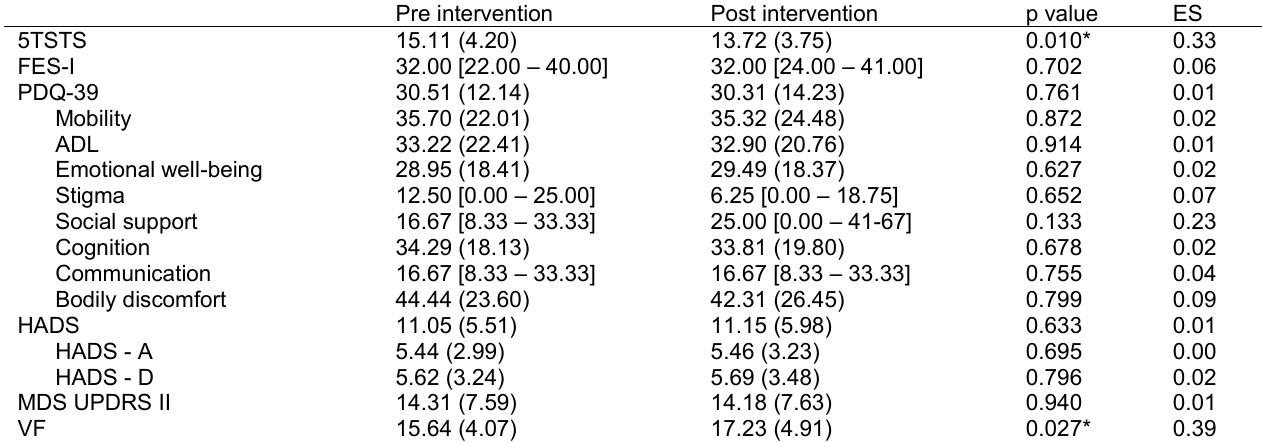
Outcomes Measures at Baseline and Changes after Intervention